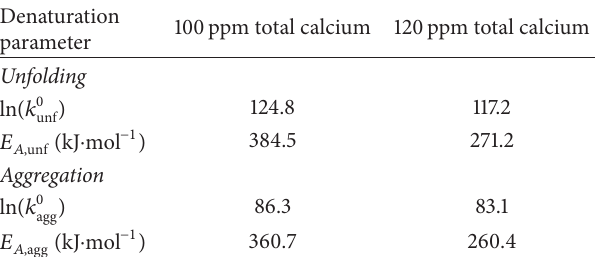
Table 3: Denaturation parameters at the two calcium concentra-